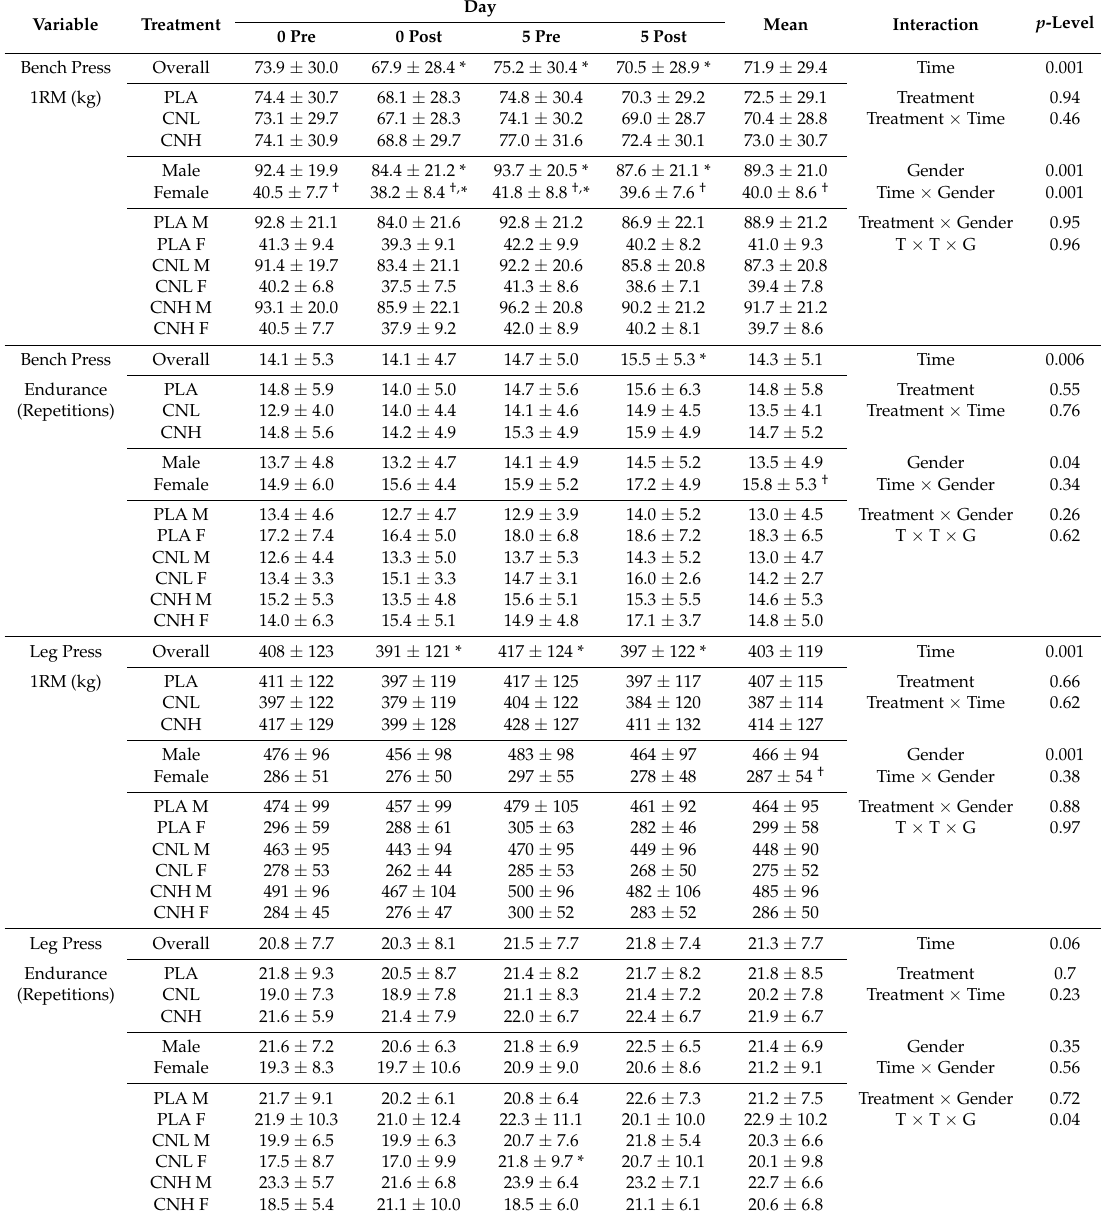
Table 2. Bench Press and Leg Press